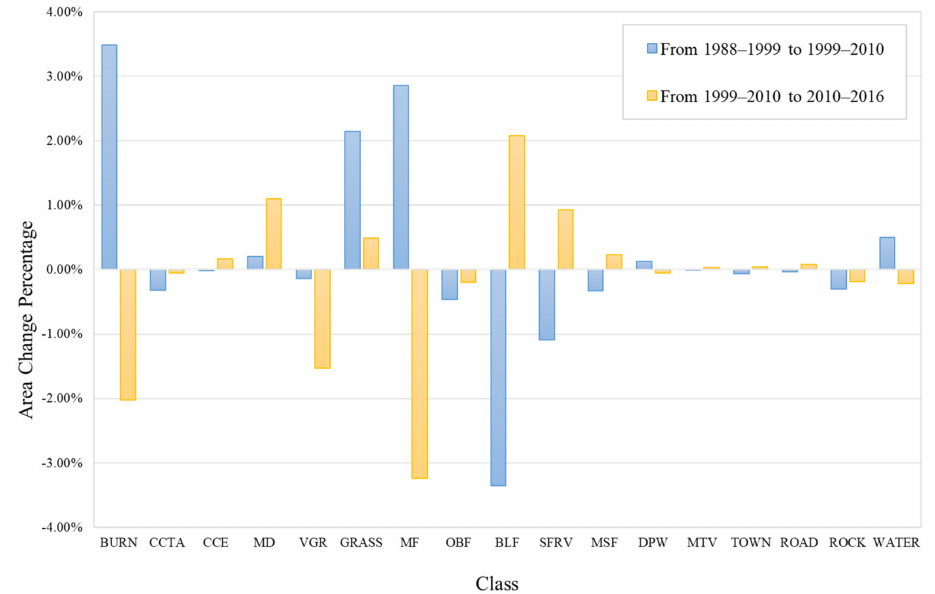
Figure 5. Area change percentage of class covers from the period of 1988–1999 to 1999–2010 and from the period of 1999–2010 to 2010–2016. BURN = burned area, CCTA = clearcutting for timber or agricultural, CCE = clearcutting for electricity lines, MD = mixed disturbance, VGR = vegetation recovery, GRASS = grassland, MF = mixed forests, OBF = oak–Daurian birch forests, BLF = birch and larch forests, SFRV = spruce forests in a river valley, MSF = mountain spruce forests, DPW = dwarf pine woodland, MTV = mountain tundra vegetation, TOWN = settlement, ROAD = unpaved road, ROCK = stream bedrocks, and WATER = water.